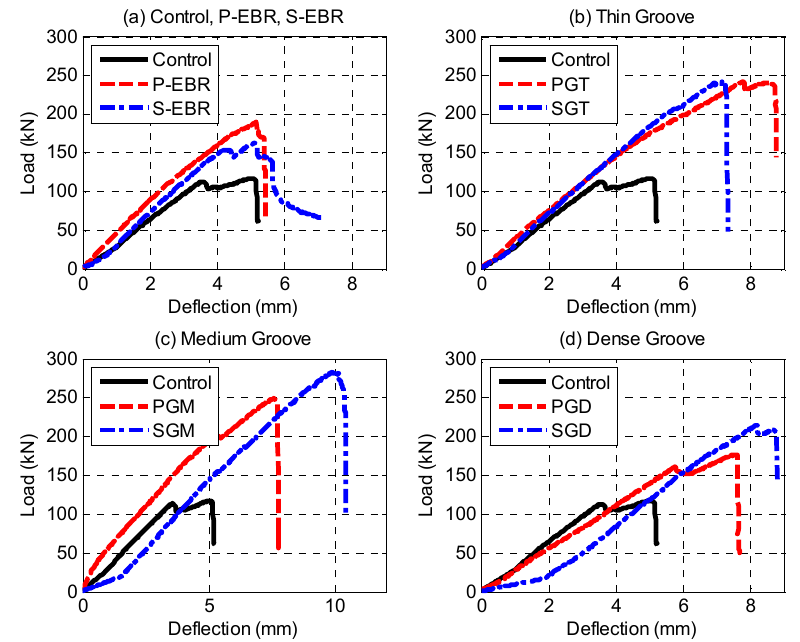
Figure 11. Load deflection curves for SGT, SGM, and SGD beam.